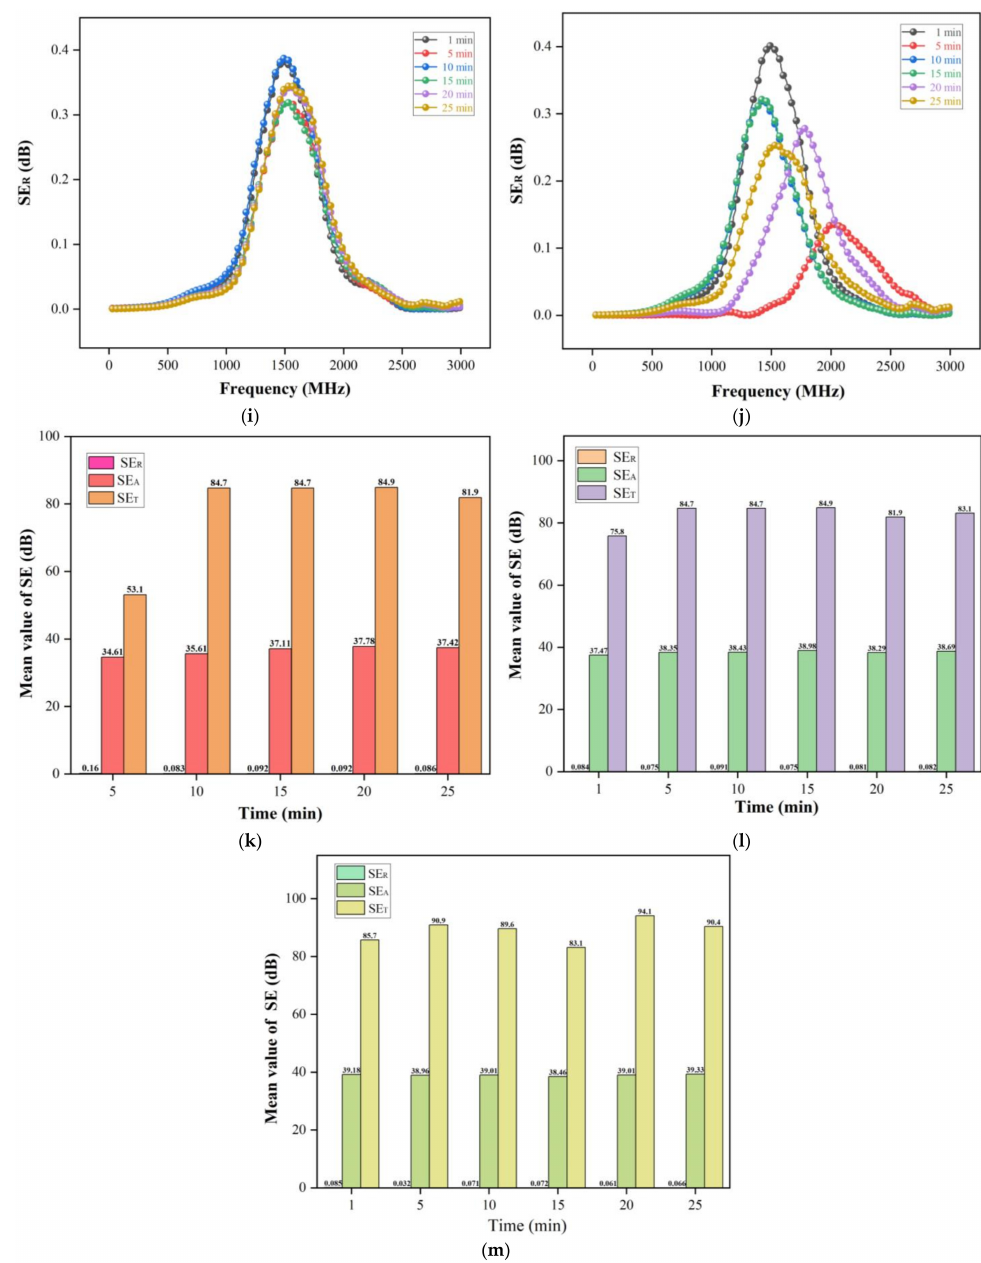
Figure 9. Electromagnetic shielding efficiency of wood metal composites: ( a ) is the relationship between electroless Ni time, times and conductivity of composites; ( b – d ) is SE T of electroless Ni for one, two and three times, respectively; ( e – g ) shows SE A of electroless Ni for once, twice and three times, respectively; ( h – j ) shows the SE R of electroless Ni for once, twice and three times, respectively; ( k – m ) is the average value of total electromagnetic shielding effectiveness of once, twice and three electroless